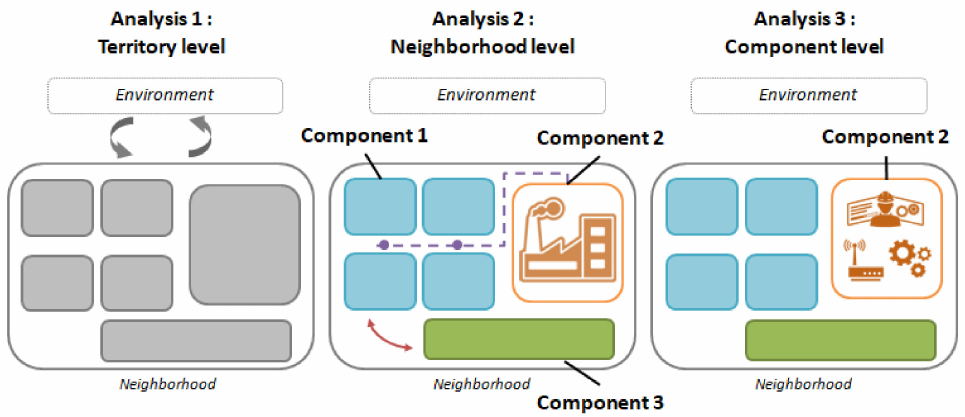
Figure 1. The DS3 Model allows three levels of analysis